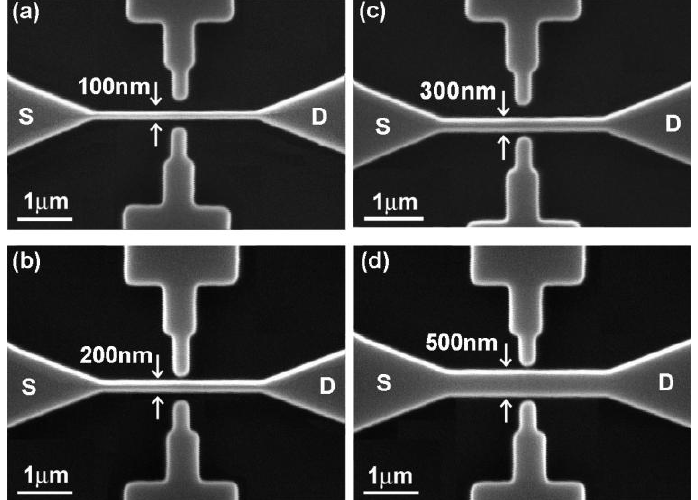
Figure 1. SEM images of the PSW sensors with channel widths of (a) 100 nm, (b) 200 nm, (c) 300 nm, and (d) 500 nm,